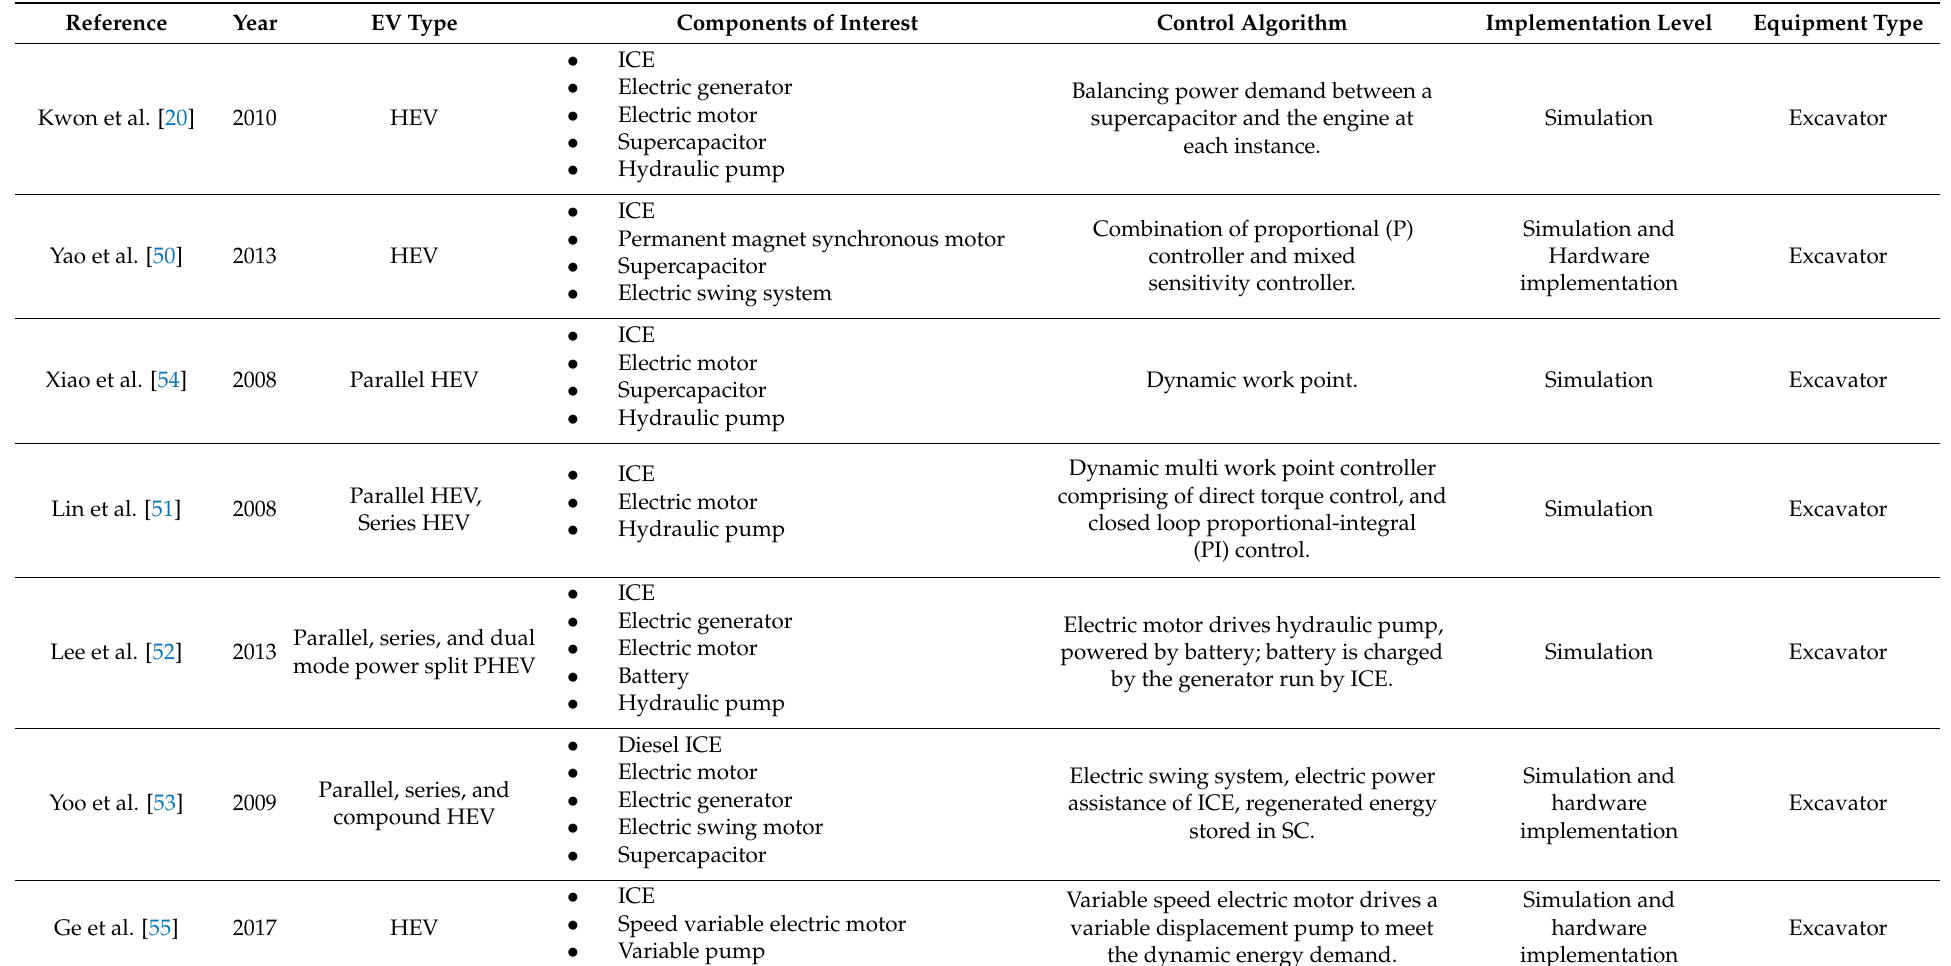
Table 3. Academic literature on electric off-road construction